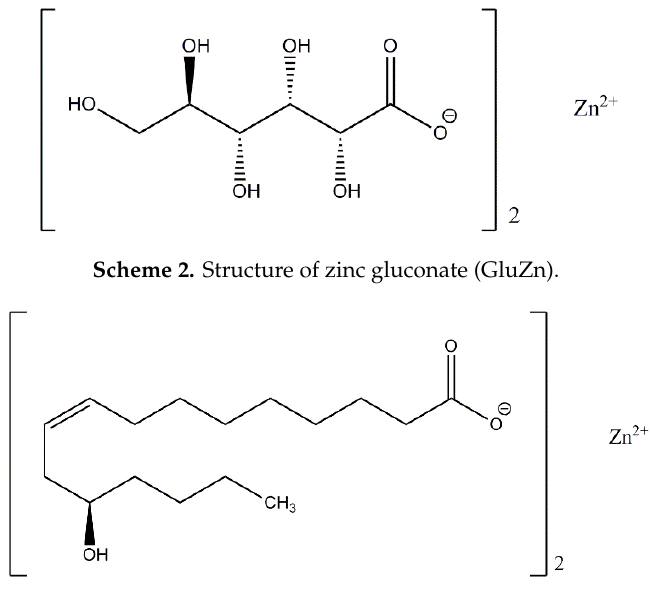
Scheme 3. Structure of zinc ricinoleate (RicZn).